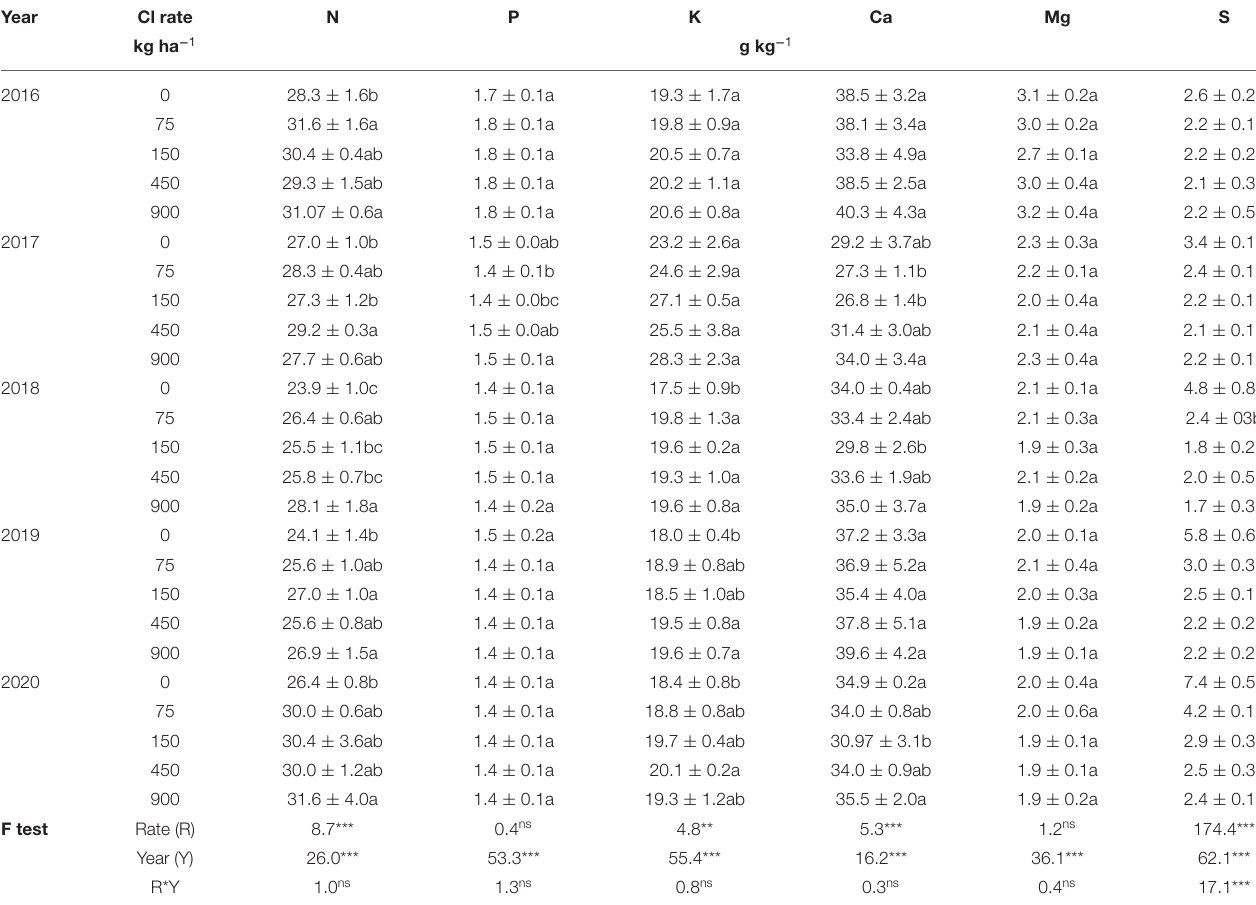
TABLE 1 | Data and statistical analysis of leaf nutrient content in